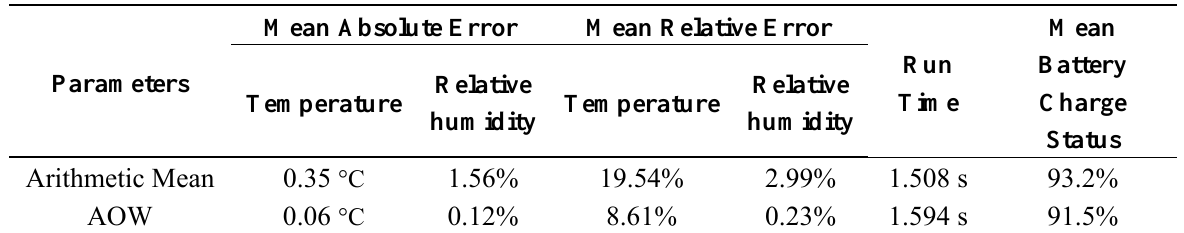
Table 2. Performance of the adaptive optimal weighted data fusion (AOW) compared to the arithmetic mean.